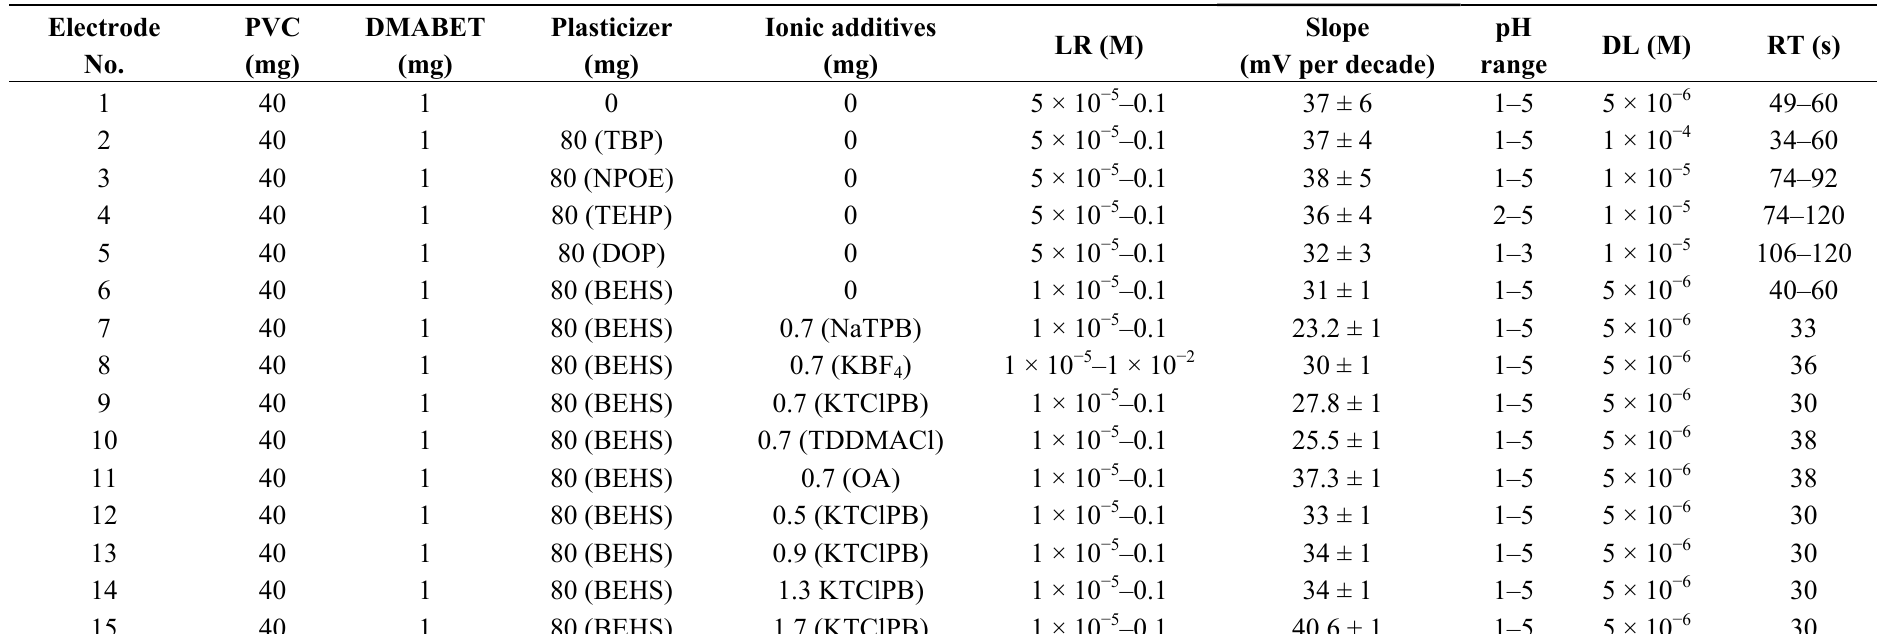
Table 2. Optimization for PVC-DMABET membrane composition 1